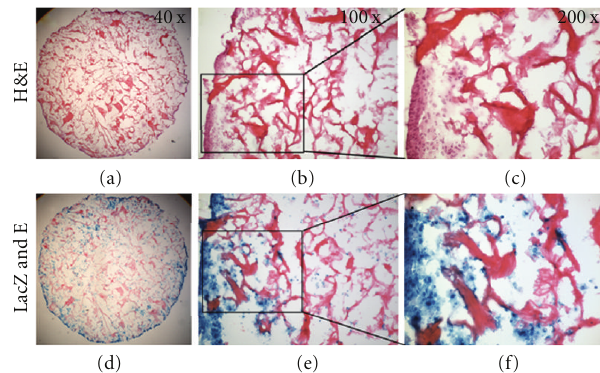
Figure 1: Cell growth examined after 1 week of culturing in vitro . Cells were visualized throughout the sca ff old with a higher concentration of cells located on the periphery of the sca ff olds; however, extensive migration is seen within the sca ff olds. H&E staining of the sca ff olds ((a)–(c)), and LacZ and eosin staining ((d)– (f)) are